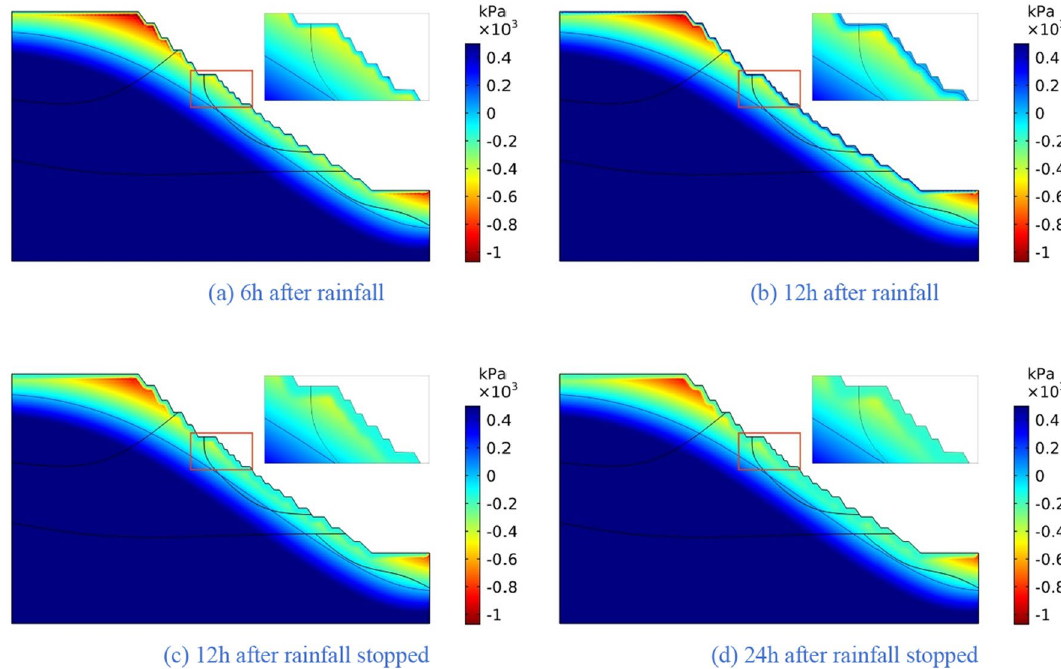
Figure 19. The pore-water pressure distribution (Scheme III).